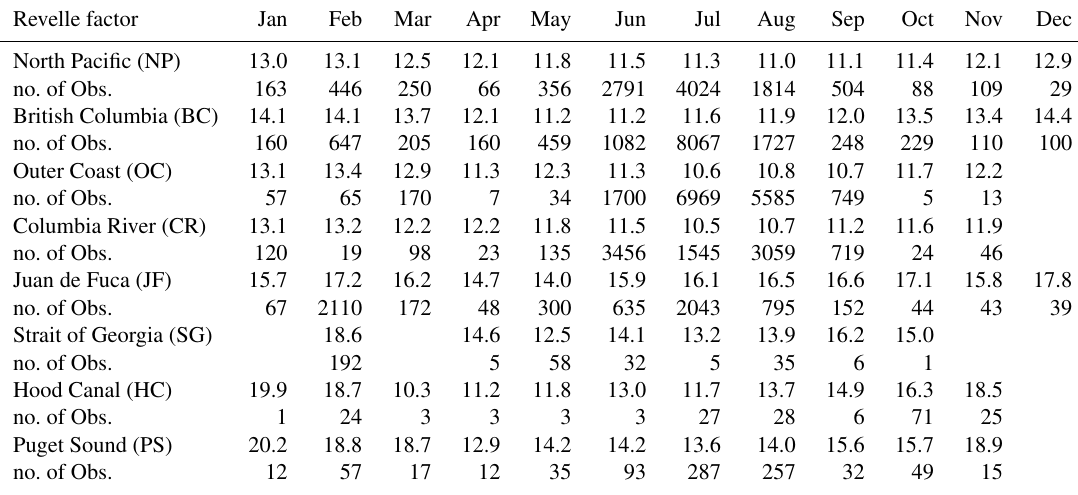
Table B8. Average monthly Revelle factor seasonal cycles for the eight unique regions. The total number of observations (no. of Obs.) contributing to the monthly average estimate is